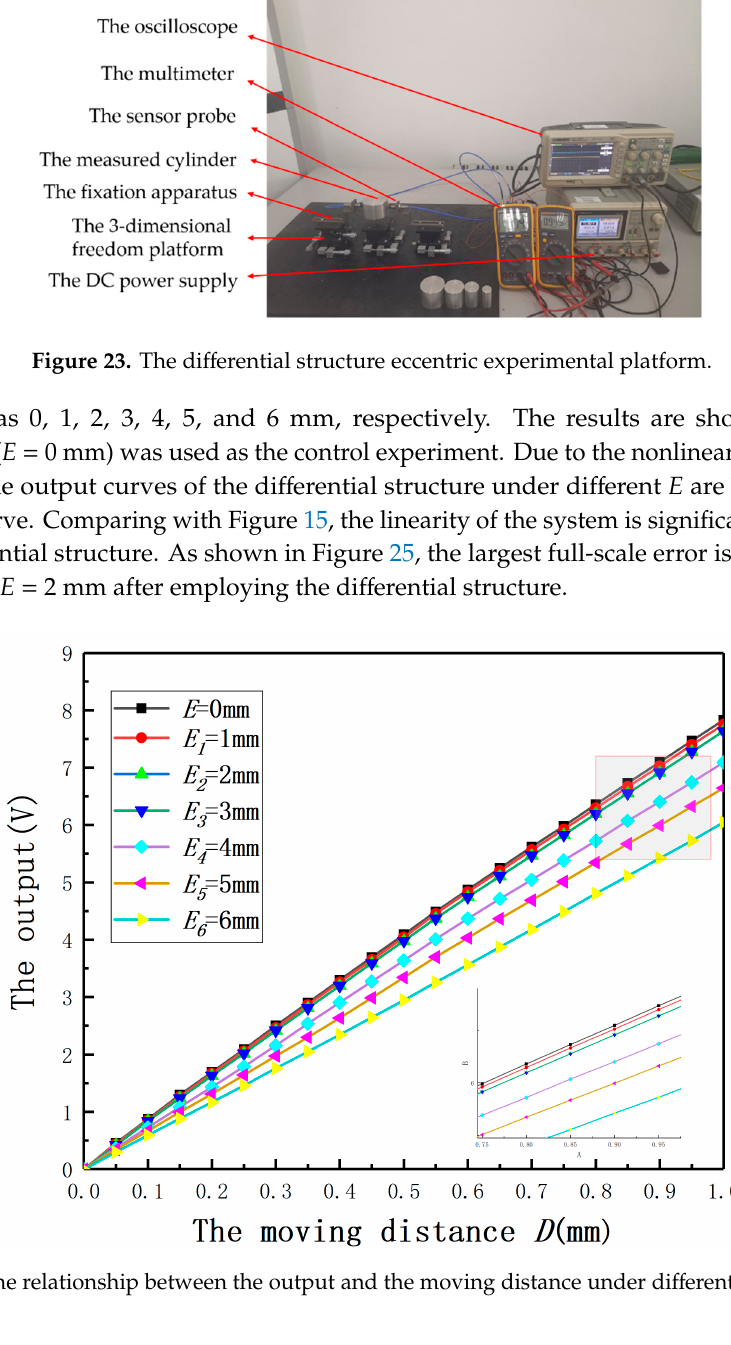
Figure 25. The largest full-scale errors with different eccentricities. It is still necessary to compensate for the measurement errors under different E . The compensation method in the differential structure is the same as the method of Section 4.3. The compensation equation is: